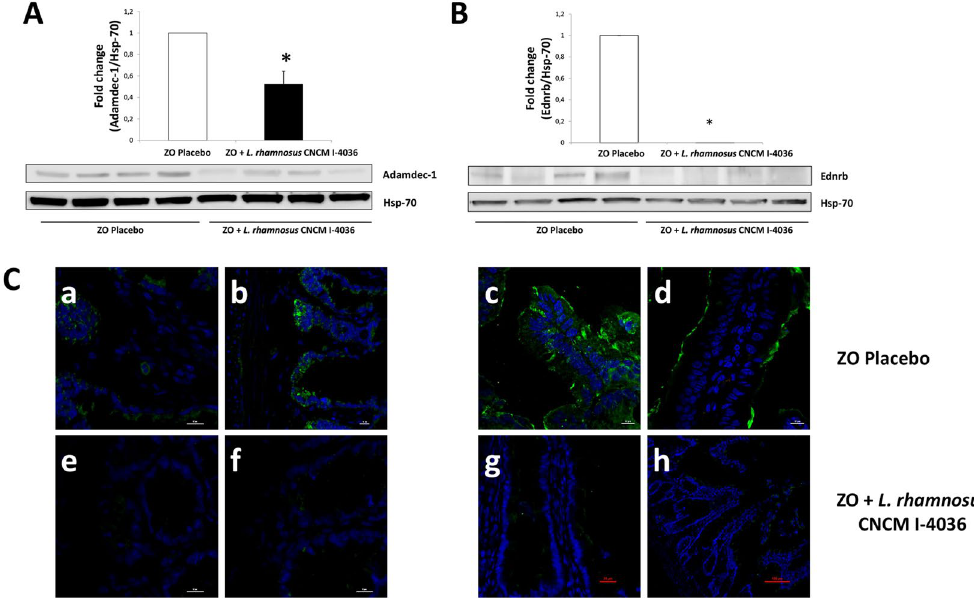
Figure 5. Immunofluorescence and western blot analysis of Adamdec1 and Ednrb proteins from Zucker- Lepr fa / fa rats fed the placebo compared with Zucker-Lepr fa / fa rats fed L . rhamnosus CNCM I-4036. In panels A and B, top graphs include 8 rats per group, and the lower parts show a representative crop blot. Hsp-70 was used as a loading control. * P < 0.05. In panel C, micrographs a,b (ZO placebo) and e,f (ZO + L. rhamnosus CNCM I-4036) show results for Adamdec1, and micrographs c,d (ZO placebo) and g,h (ZO + L . rhamnosus CNCM I-4036) show results for Ednrb. The green color corresponds to Alexa Fluor 488 dye. ZO, Zucker-Lepr fa / fa rats.